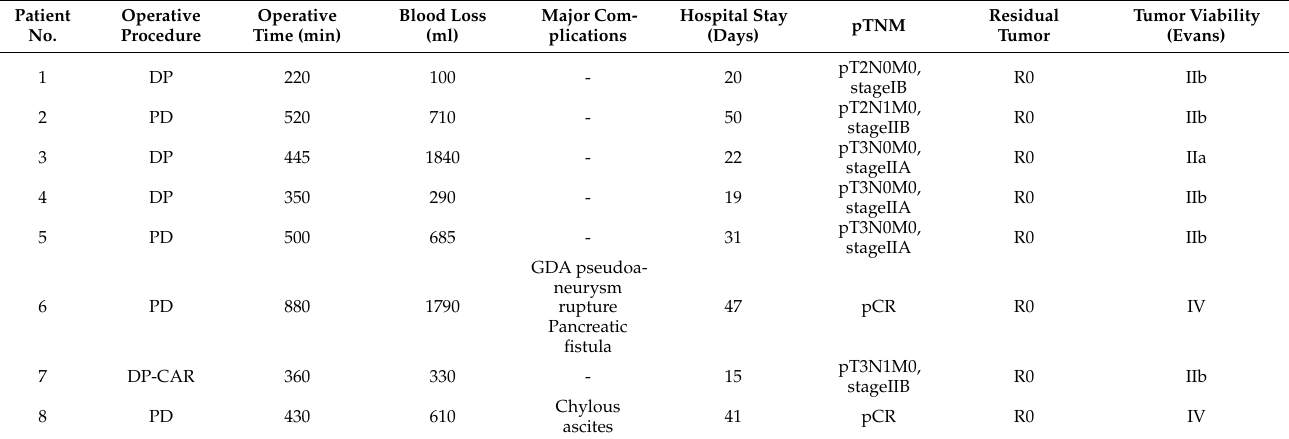
Table 4. Surgical outcomes and pathological findings.